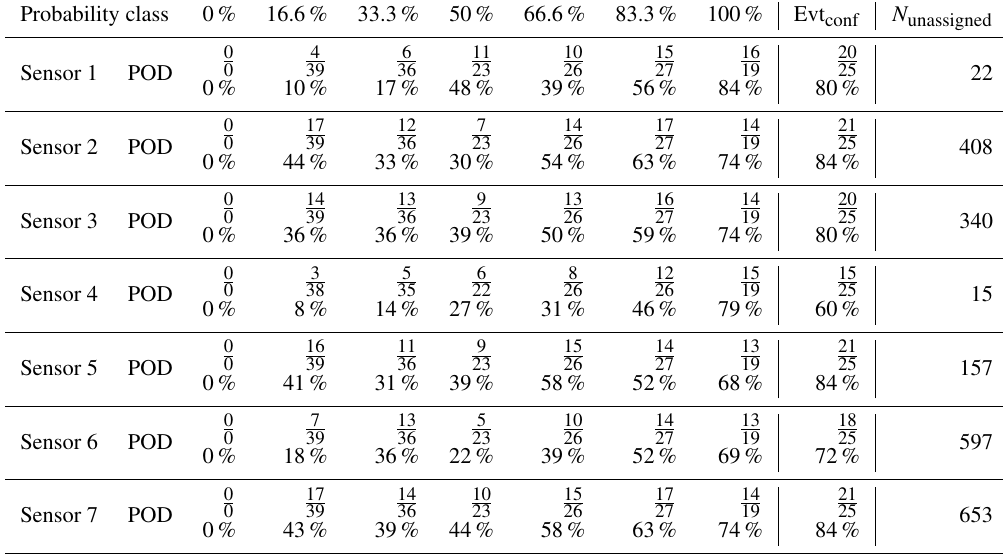
Table 3. Number of detections ( N hit ) and probability of detection (POD) for each sensor and each probability class as well as the POD for confirmed events Evt conf and number of events that were not in the reference data set ( N unassigned ) using a minimal event duration of T min =